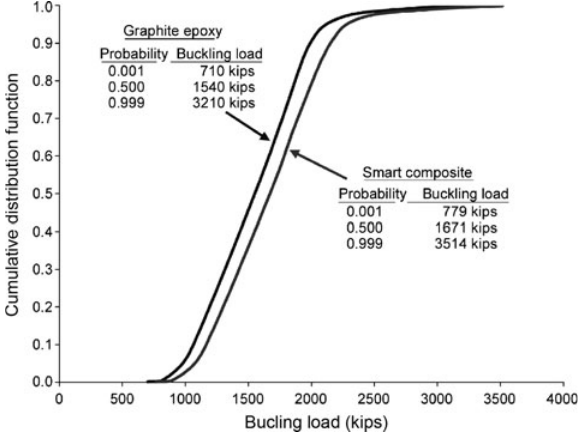
Figure 7 Probabilistic evaluation of dynamic buckling load of graphite epoxy and smart composite shells. (1 kip = 4.45 KN.)